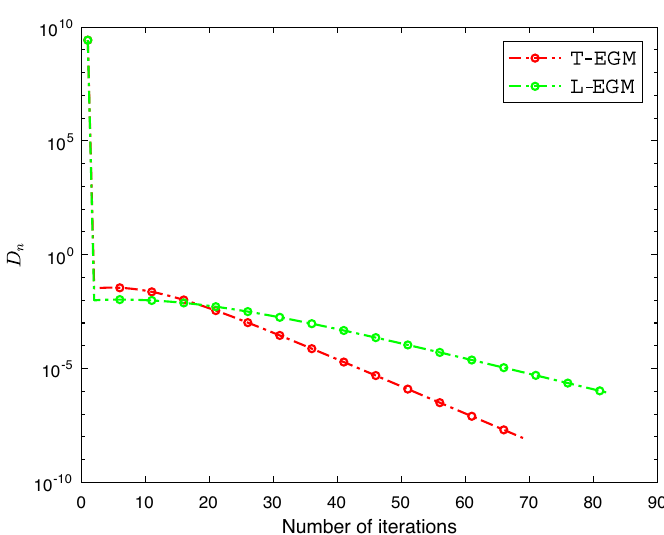
Figure 7: Numerical illustration of Algorithm 1 in [ 28 ] and Algorithm 1 in [ 29 ] while